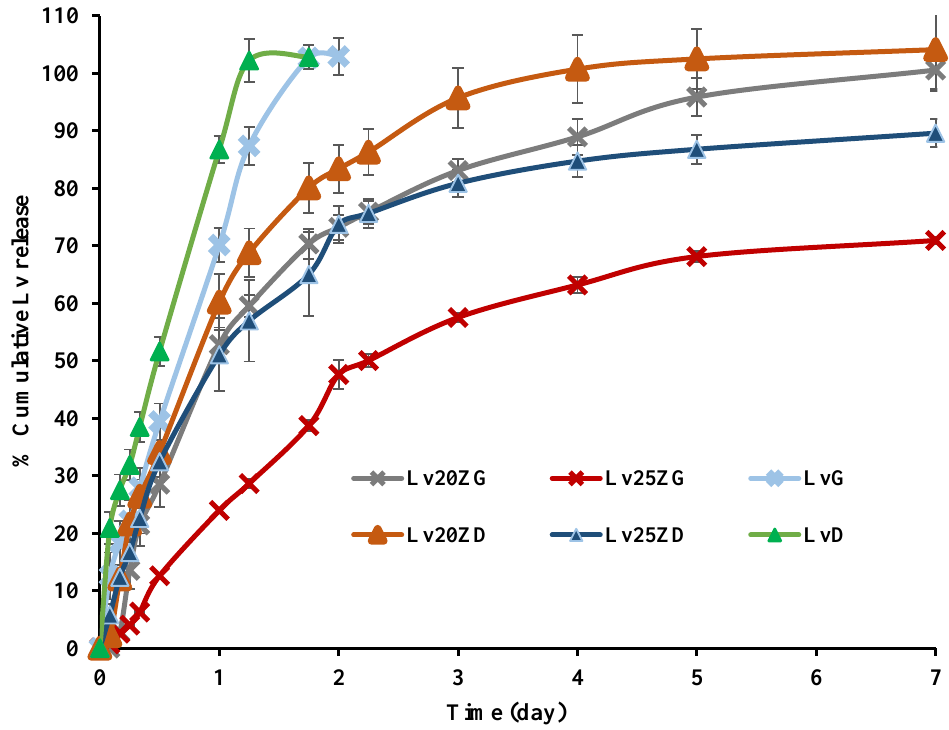
Figure 5. Release of Lv from zein-based ISGs formulations using the cup method ( n = 3). For non-swellable cylindrical matrices, the values of n from the Korsmeyer – Peppas equation are 0.45 and 1.0 for Fickian and case-II transport, respectively [62]. When the value of n is >0.45 and <1.0, the release was claimed as non-Fickian [62,63]. A value of n = 1 indicates a zero-order release [63,64]. The regression coefficient (r 2 ) value and diffusion exponent value ( n ) obtained from the drug release profile of Lv-loaded zein-based ISGs fitting to different mathematical equations are shown in Table 3. The best model that mostly complied with release profiles was the first-order kinetic indicating that drug re- lease was a fraction of the remaining drug in the matrix. Therefore, Lv release is mainly driven by diffusion of the medium into the zein composite matrix. Nonetheless, the drug release from other matrix-forming agent-based ISGs fabricated from polymers or fatty